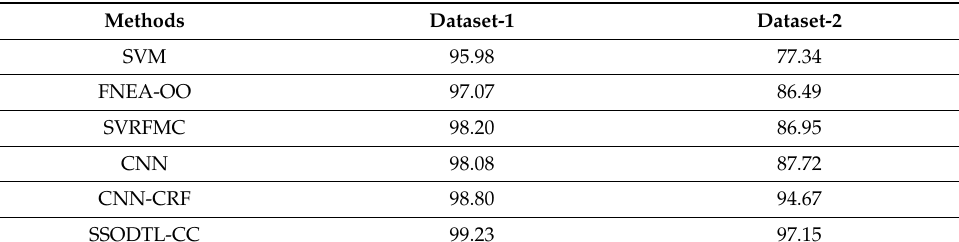
Table 7. Comparative analysis of the SSODTL-CC technique with recent algorithms in terms of accu y .